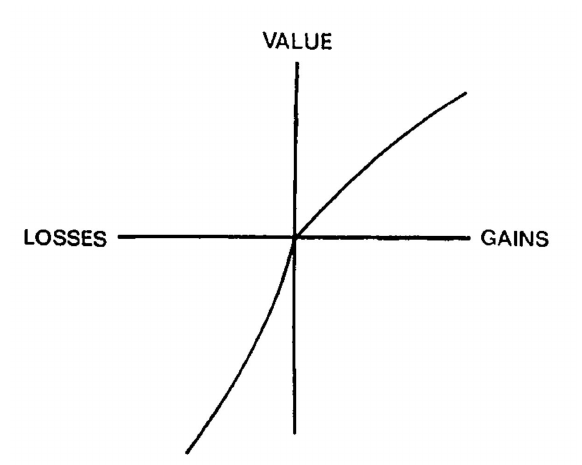
Figure 12. Prospect